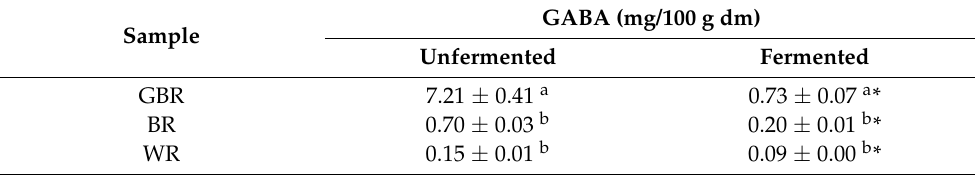
Table 3. Effect of fermentation on the γ -aminobutyric acid (GABA) contents of rice samples. Sample